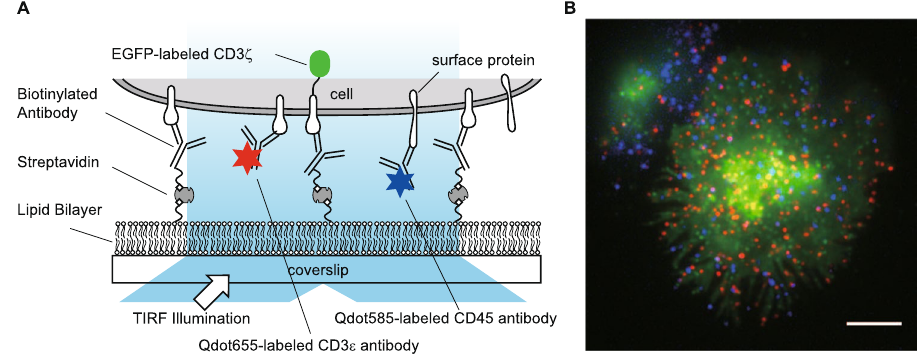
Figure 1. Simultaneous triple-color single-molecule observation using planar lipid bilayers. ( A ) Schematic illustration. ( B ) Representative image of simultaneous three-color single-molecule observation of CD3 ζ -EGFP (green), Qdot 655-labeled CD3 ε (red), and Qdot 585-labeled CD45 (blue) in living Jurkat cells at 37 °C. Bar, 5 μ